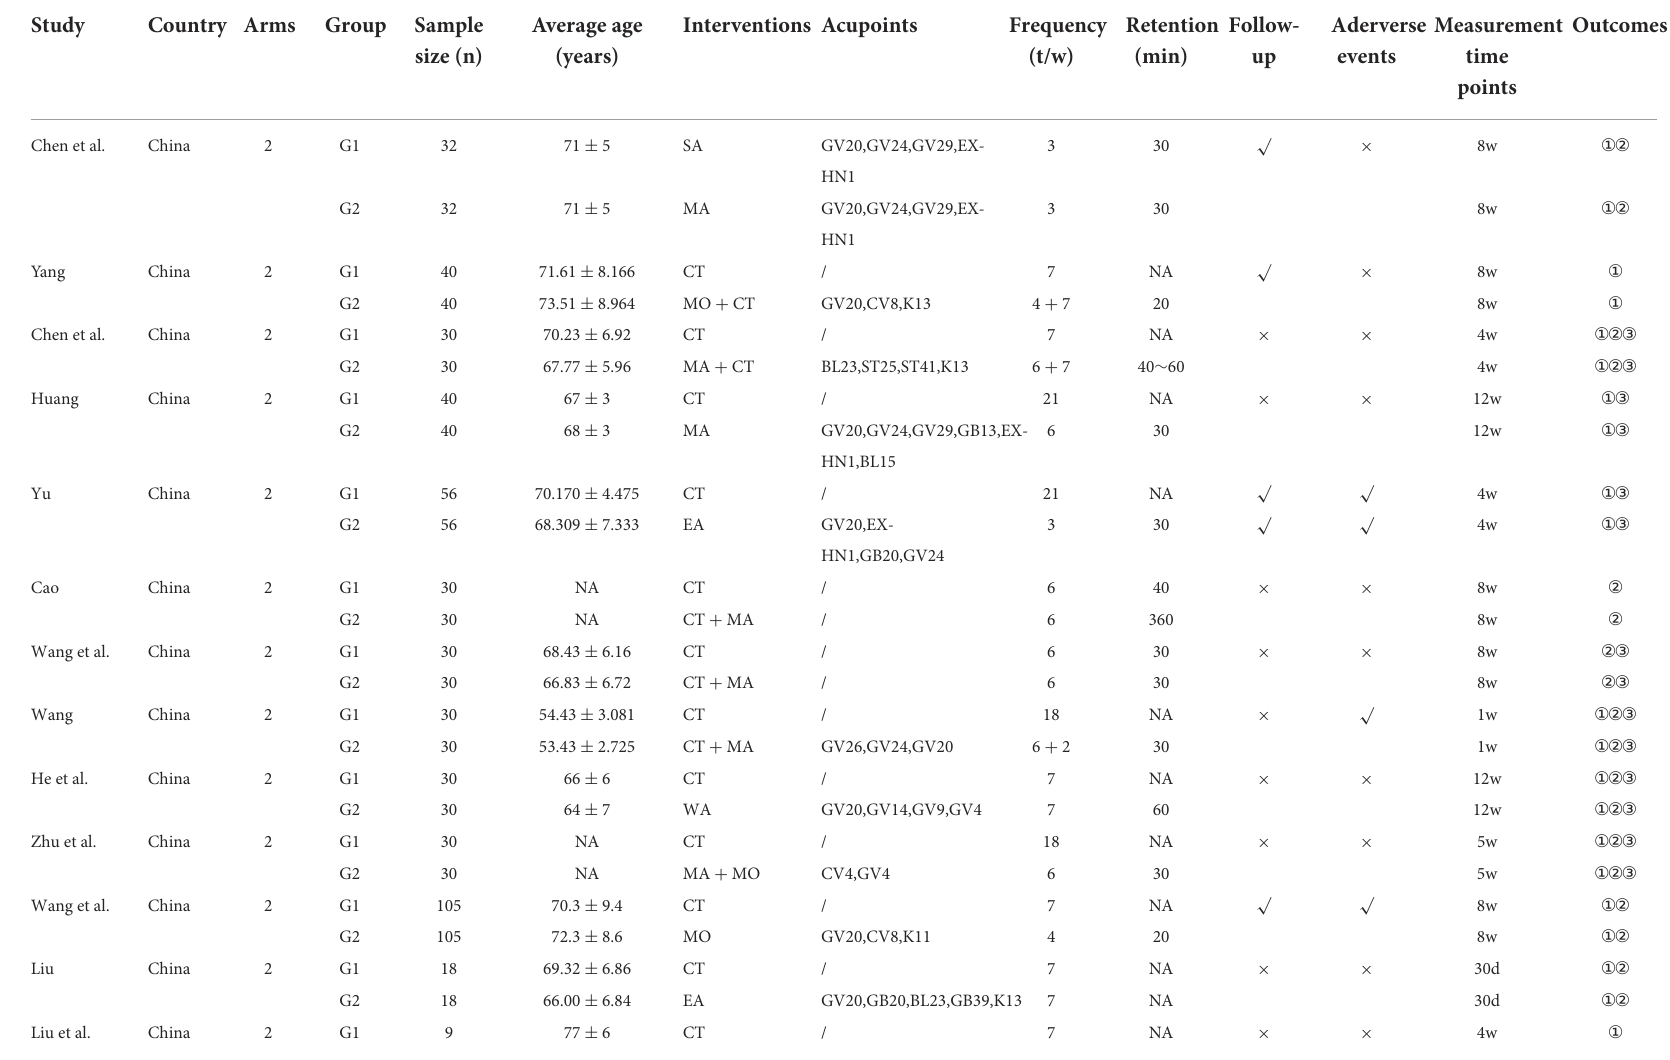
TABLE 1 Main characteristics of included